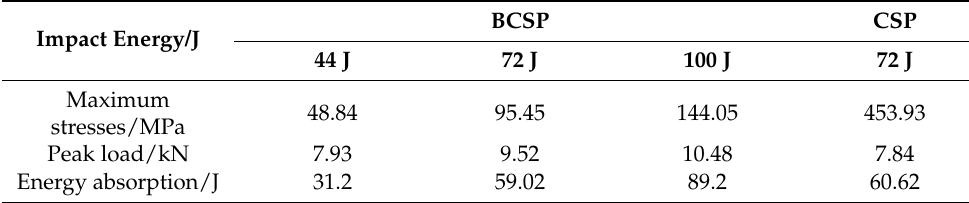
Table 4. Summary of the numerical prediction value with various impact energies.